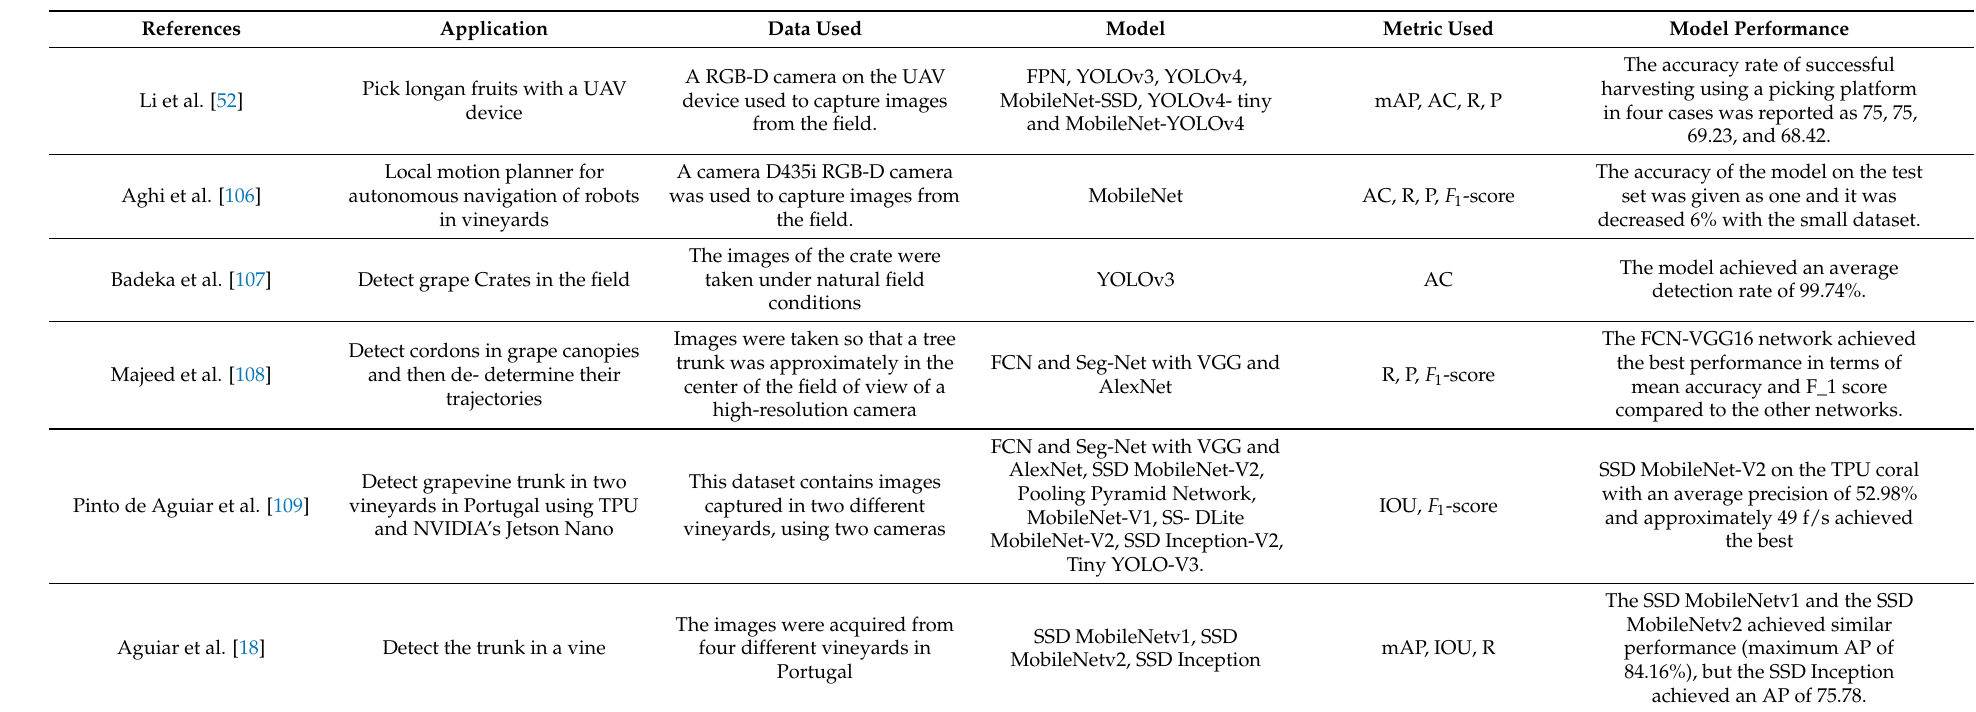
Table 9. Feature descriptions of recent published papers in the field of “Automation in